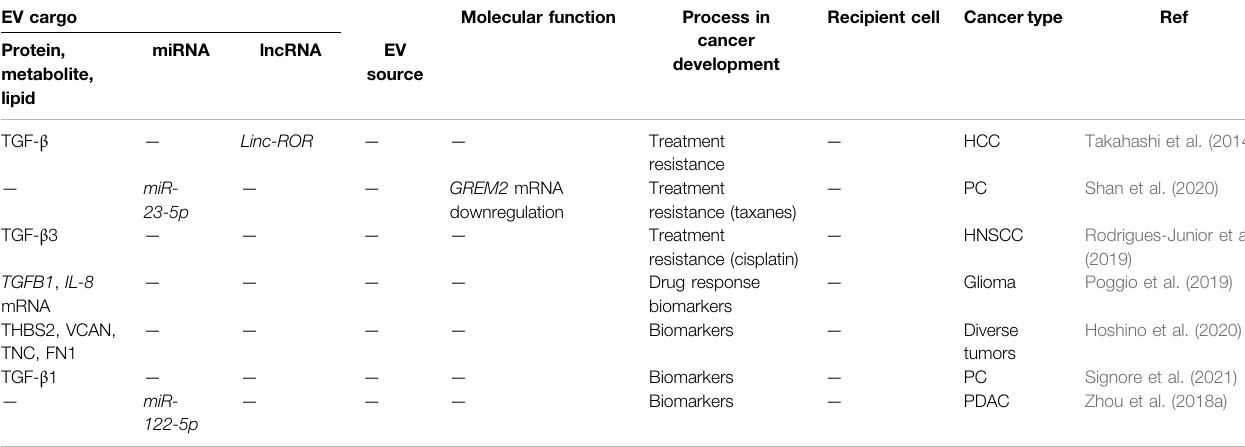
Table listing EV cargo in groups (proteins, metabolites, lipids, miRNAs, lncRNAs), EV source, function of the molecule, cancer process involvement, recipient cell, cancer type and the correspondingreference.Emptyentriesindicatelackofinformationorlackofrelevance.ThevalidityofthesereportedEVcargoeshasbeencriticizedinthetextandcautionissuggestedto the careful reader of the table. EV cargoes are listed in the same order as they appear in the main text. Cancer type abbreviations: AML, acute myeloid leukemia; BRCA, breast cancer;